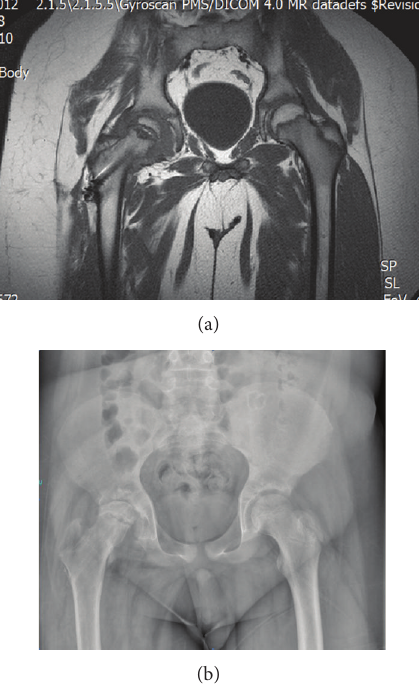
Figure5:(a)One-yearfollow-upmagneticresonanceimagingstudy showsnosignsofavascularnecrosis;(b)thescrewremovedafterone